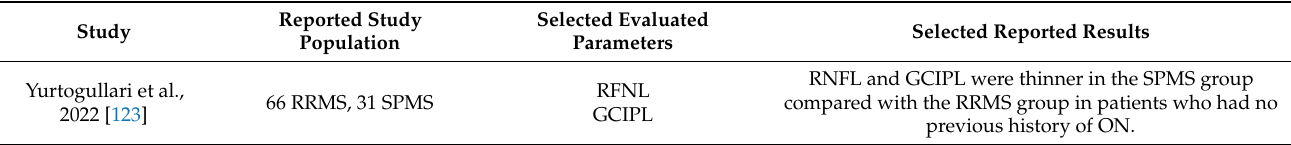
Table 2. Studies regarding selected OCT parameters’ role as biomarkers for differentiating RRMS and PMS